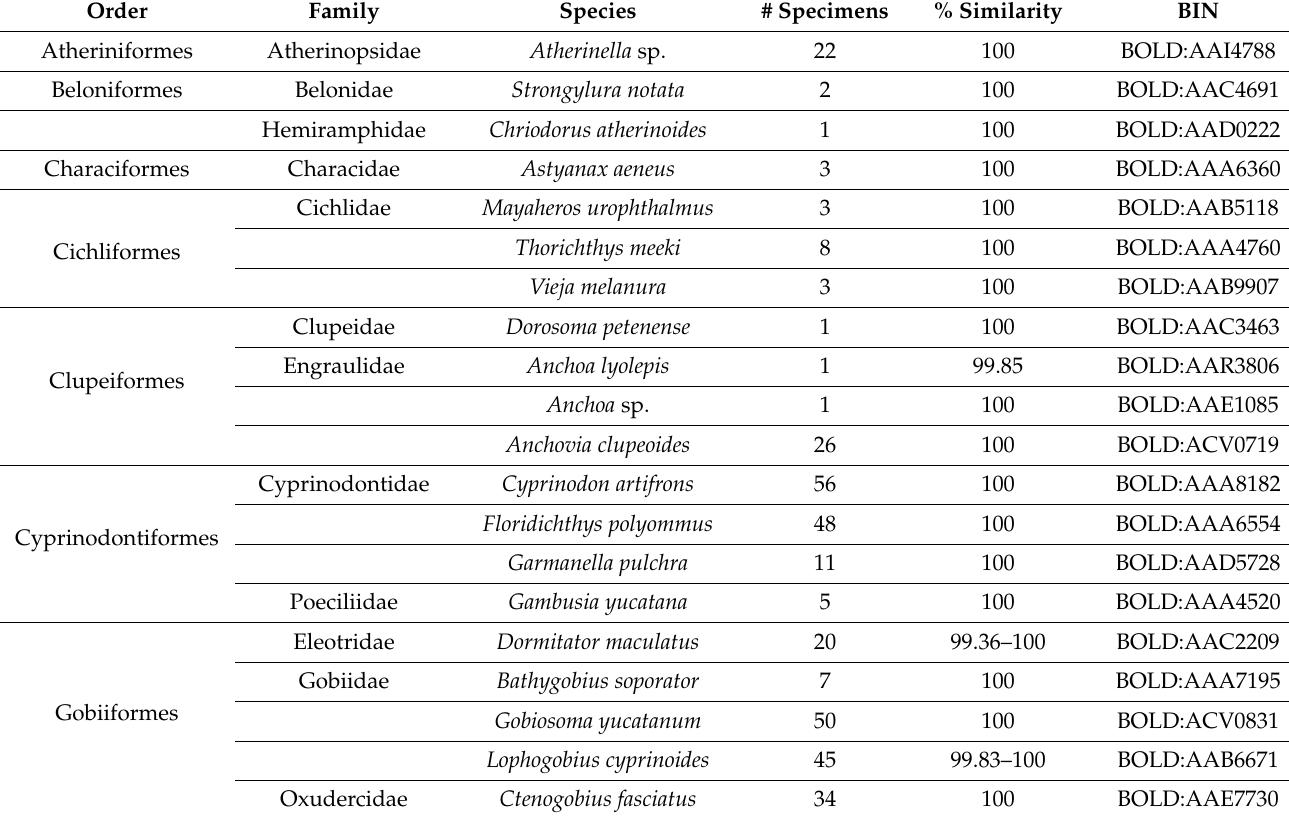
Table 2. Species and genus list detected with Barcodes with their BINs